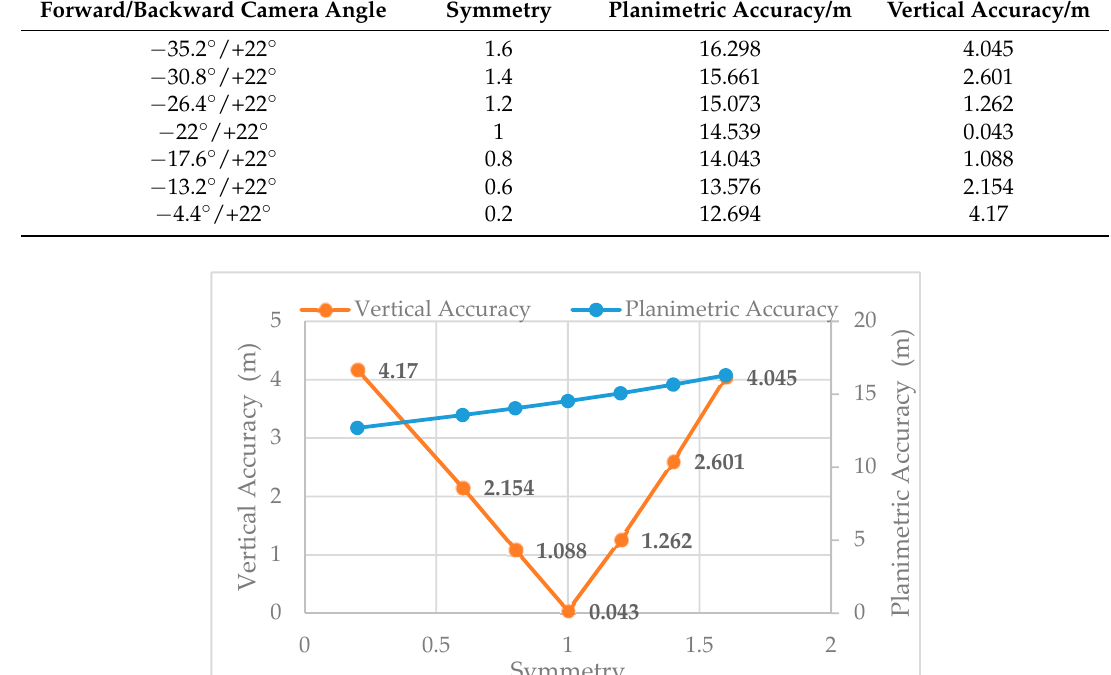
Table 4. Vertical accuracy simulation of stereo images under the same base:height ratio.